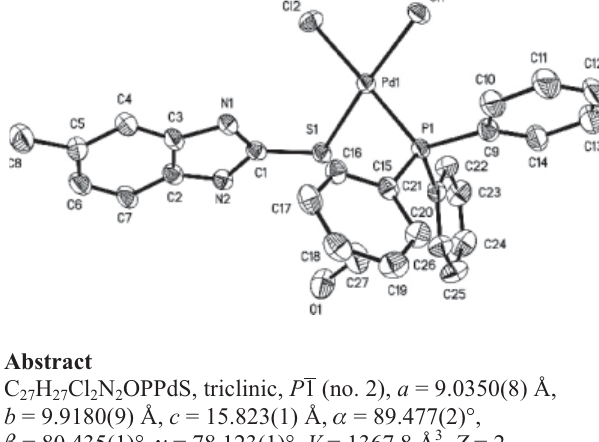
2.381(2) Å / 2.316(2) Å are similar to those in shorter than the corresponding distance in [PdCl 2 (PPh 3 ) 2 ]·2CHCl 3 (2.293(2) Å) [6]. The distortion from